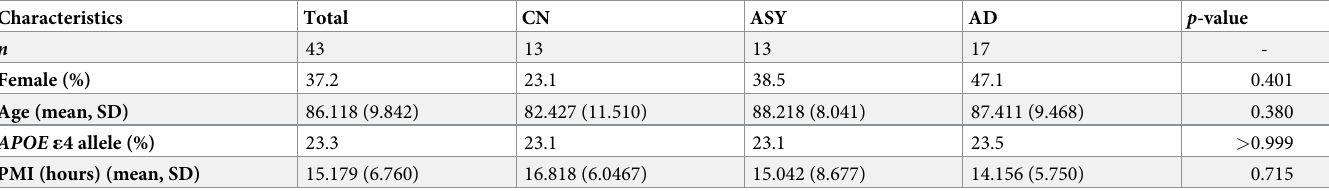
Table 1. Demographic characteristics of the BLSA autopsy sample.